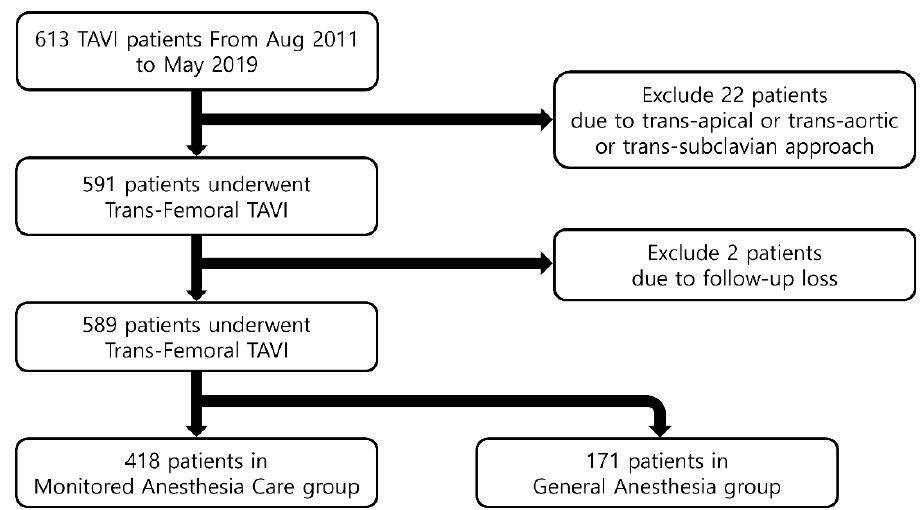
Figure 1. Diagram of the patient flow chart. TAVI, transcatheter aortic valve implantation; Aug, August. Table 1. Baseline demographic and clinical characteristics of patients who underwent transcatheter aortic valve replacement under MAC or GA. Values are presented as the mean (standard deviation) or number (percentage).